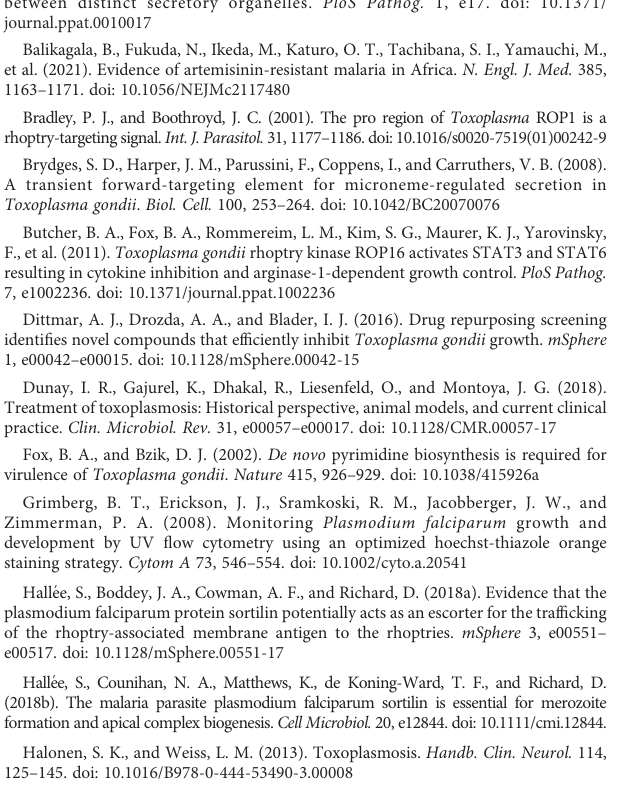
SUPPLEMENTARY TABLE 1 Columbus image analysis script. SUPPLEMENTARY TABLE 2 Small molecules, their corresponding chemical structures and functions based on the Tocris library data. SUPPLEMENTARY TABLE 3 Four drugs (30%) among the twelve inhibitors identi fi ed during our screening are not present in those reported by Ditmer et al.